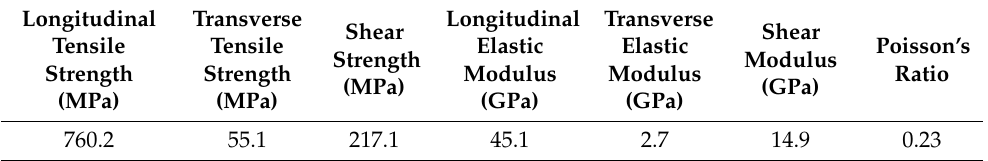
Table 3. Mechanical property indexes of composite